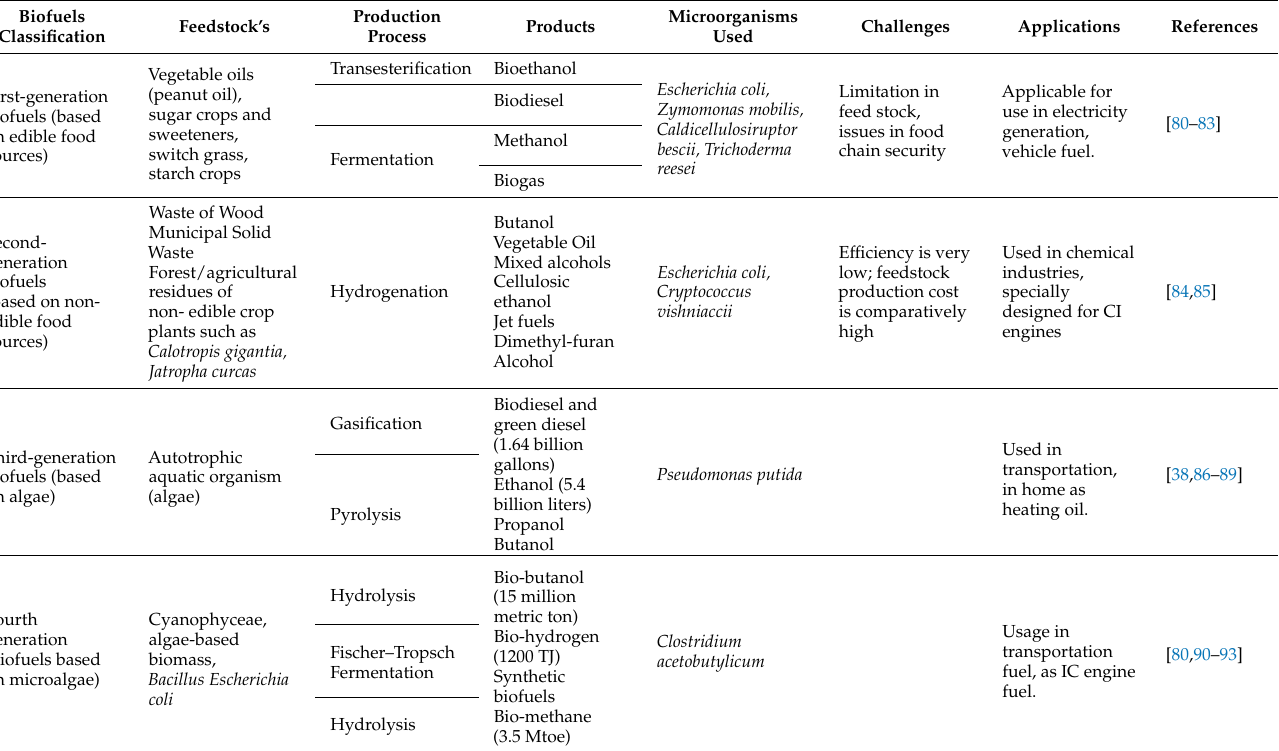
Table 2. Tabular representation of different feedstocks’ composition, methods of production, chal- lenges, and applications for the production of